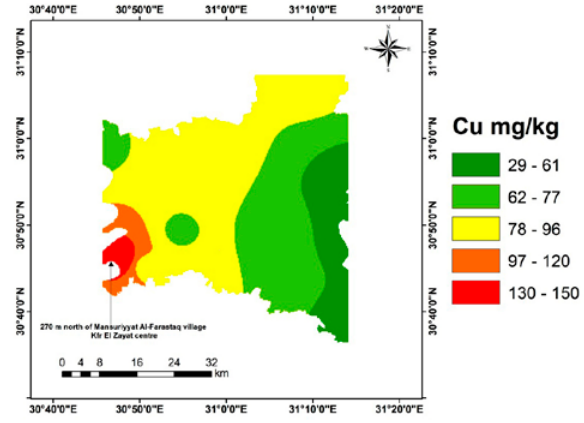
Fig. 7. Spatial interpolation of the weighted mean of